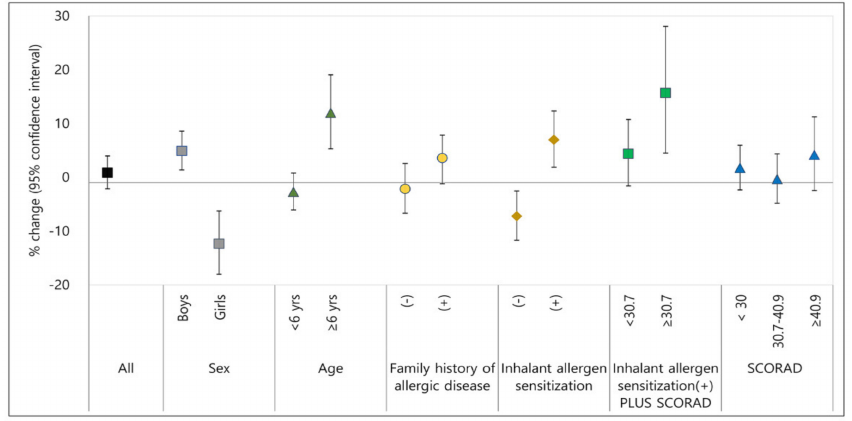
Figure 3. Percent changes of atopic dermatitis symptoms caused by PM 2.5 exposure. % change in AD symptoms per 10 µ g/m 3 of PM 2.5 exposure; dot or square indicate % change in AD symp- toms per 10 µ g/m 3 of PM 2.5 exposure and lines are 95% confidence interval; SCORAD, SCORAD at